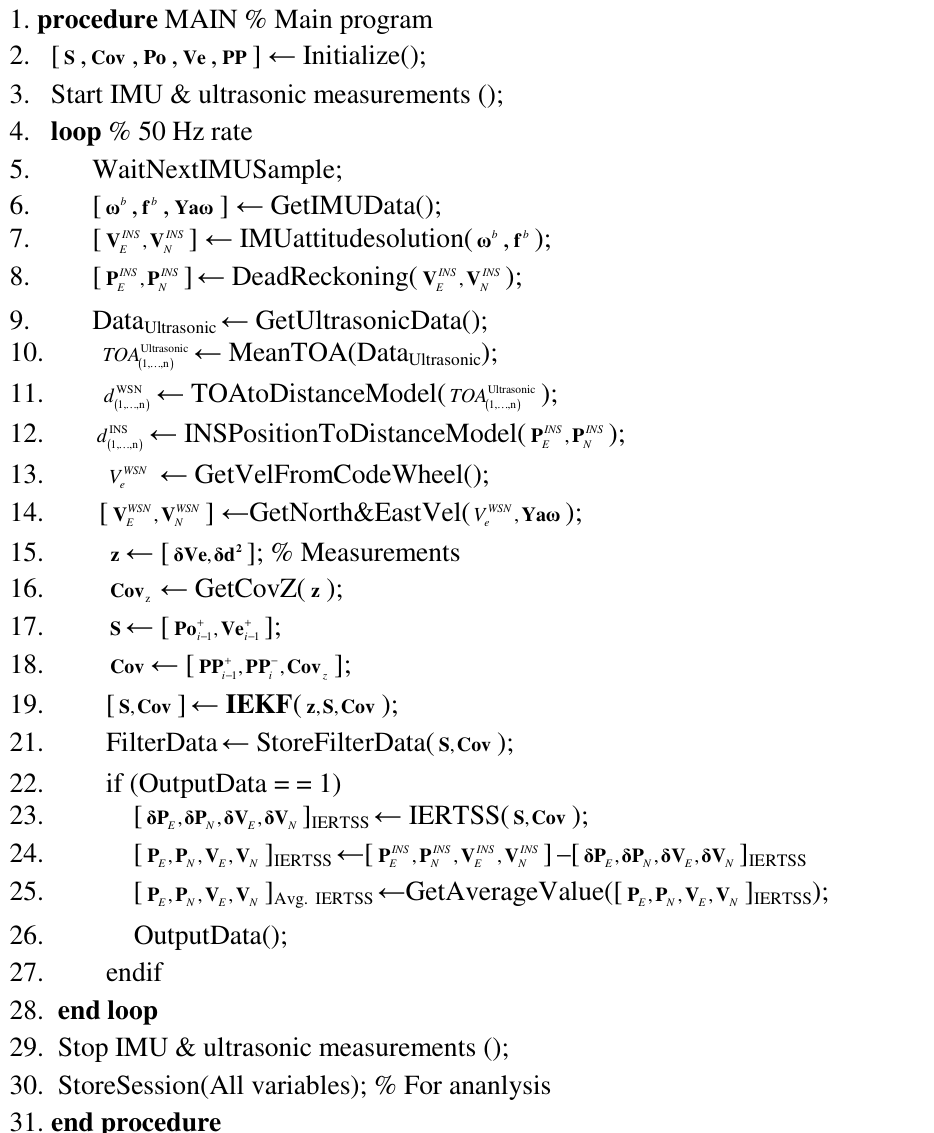
Table 2. The pseudocode of the proposed